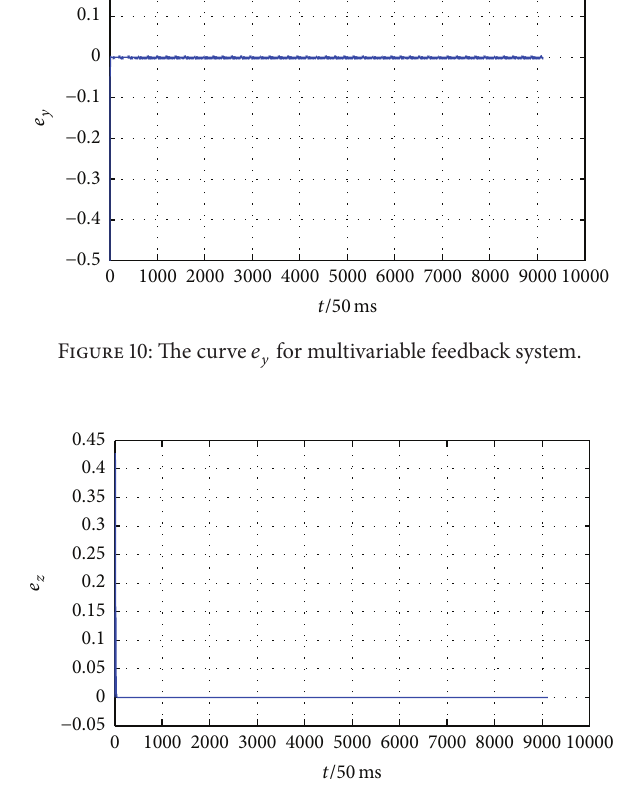
Figure 11: The curve 𝑒 𝑧 for multivariable feedback system.